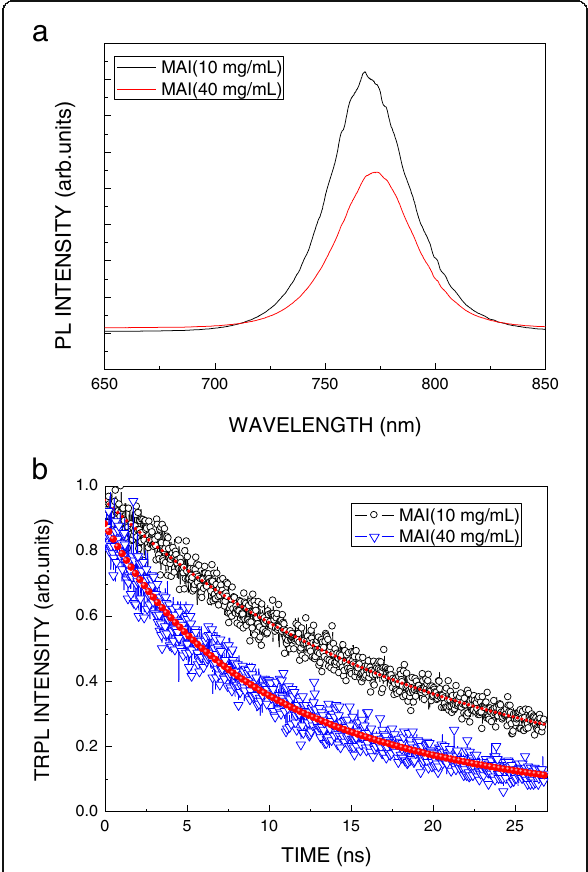
Fig. 7 a PL and b TRPL spectra of MAPbI 3 films with different concentrations